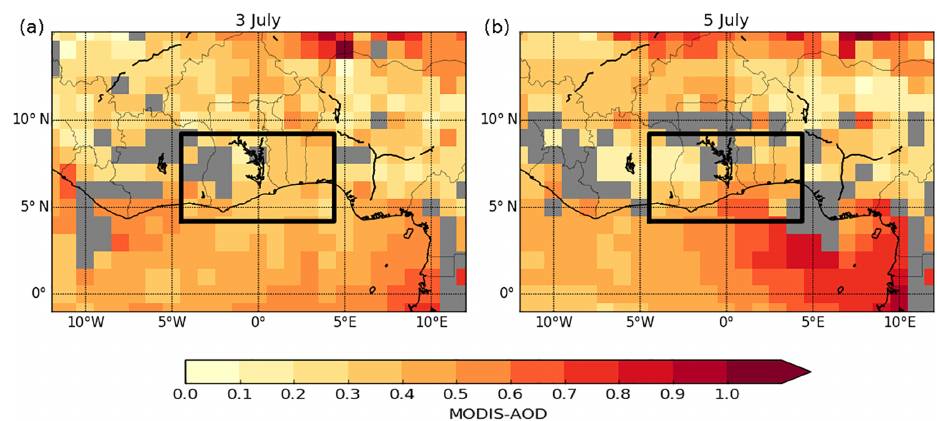
Figure 2. MODIS AOD 1-day moving average of two products acquired by Aqua and Terra (the combined Dark Target and Deep Blue MYD08-D3 and MOD08-D3 products, respectively) on 3 July 2016 (a) and 5 July 2016 (b) . Data excluded by the cloud screening process are in gray. The modeling domain is presented by the black